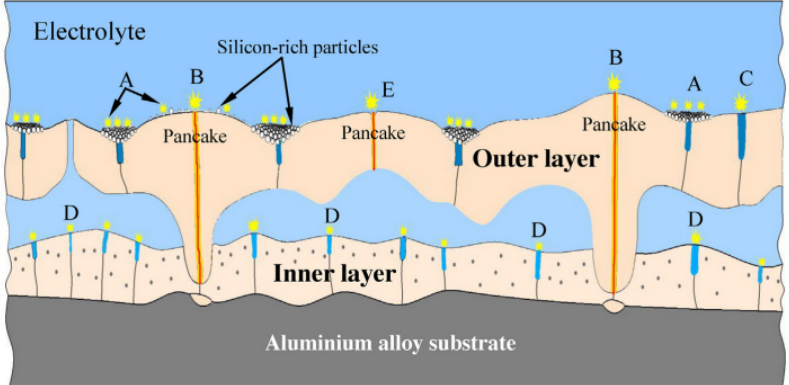
Figure 3. Extension of the layer formation model MAO taking into account the type E discharges